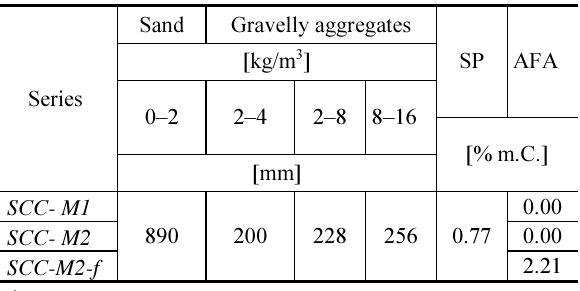
Table 5. The mix composition of self-compacting mixes,